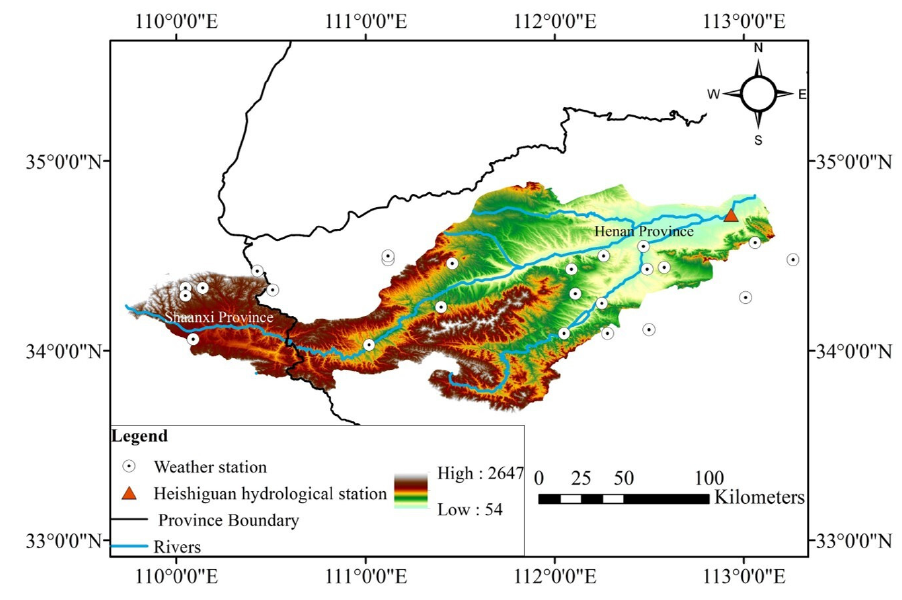
Figure 1. Location of the Yiluo River Basin.